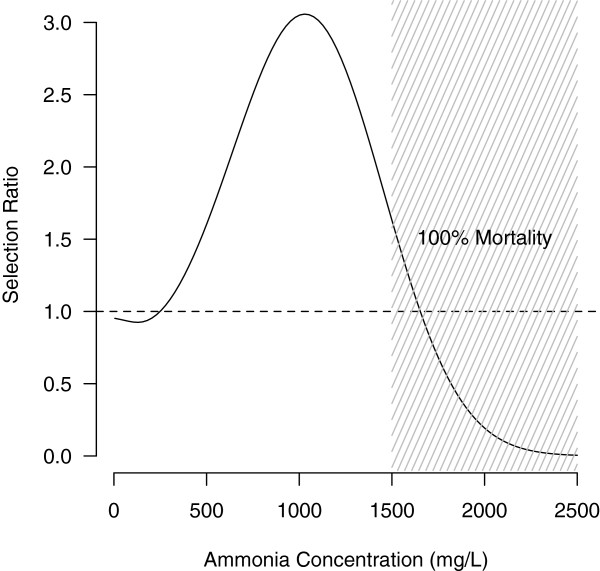
Estimated relative frequency of M-form vs. S-form survivors (Selection Ratio) when culling a mixed M/S larval population using increasing ammonia concentrations. A Selection Ratio of one (horizontal dashed line) corresponds to equal numbers of M and S survivors. Values above this line identify the region where M-form survivors exceed S-form survivors, and vice versa for values below the line. Shading identifies the range of concentrations for which observed larval mortality was 100% in both forms.